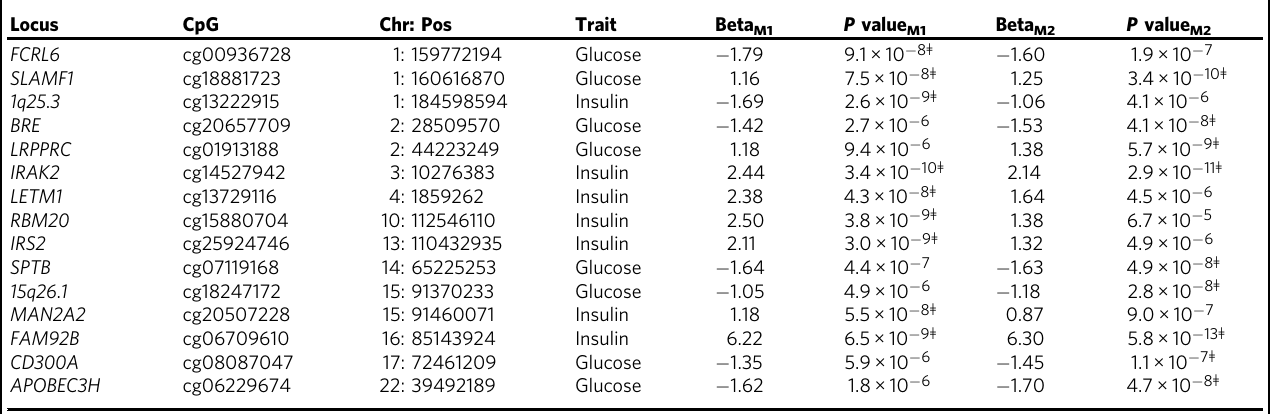
Table1 CpG sites associated with glycemic traits in discovery phase Locus CpG Chr: Pos FCRL6